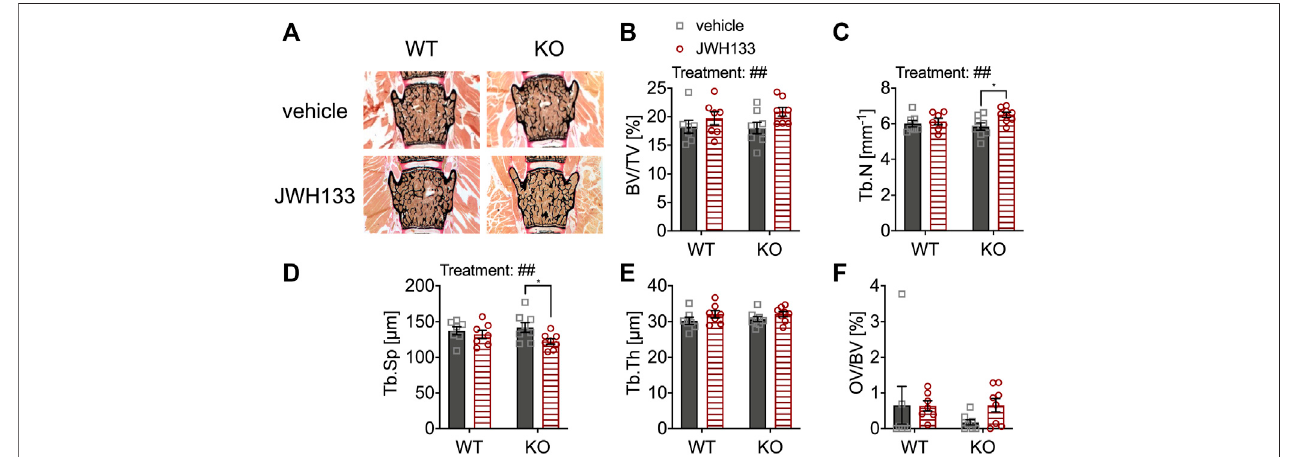
FIGURE 3 | JWH133 increased trabecular bone volume in mice. (A) Undecalci fi ed vertebral bodies (L4) stained after von Kossa/van Gieson (black = mineralized bone,red=osteoid)ofWTandp62KOmicethatweretreatedwitheithervehicleorJWH133. (B) Bonevolumepertissuevolume(BV/TV)wassimilarbetweengenotypes but was signi fi cantly increased by the treatment. (C) Trabecular number (Tb.N) was signi fi cantly increased by the treatment, and Bonferroni post hoc testing revealed a signi fi cant increase in JWH133-treated p62 KO mice compared to vehicle-treated p62 KO mice. (D) Trabecular separation (Tb.Sp) was signi fi cantly reduced by JWH133, and Bonferroni post hoc testing revealed a signi fi cant reduction in JWH133-treated p62 KO mice compared to vehicle-treated p62 KO mice. (E) Trabecular thickness(Tb.Th)wassimilarbetweengenotypesandshowedaweaktrendofthetreatmenttoincreasethethickness. (F) Osteoidvolumeperbonevolume(OV/BV)was increased in p62 KO mice after JWH133 treatment but did not reach signi fi cance due to high variability. Male mice were aged 3 months by the beginning of the experiment and were treated for 5 days with vehicle or JWH133. Data were analyzed by using ordinary two-way ANOVA and Bonferroni adjusted p values, * p < 0.05, ** p < 0.01, *** p < 0.001. All error bars show mean ± SEM. Squares and circles represent individual data points. WT vehicle N = 7, KO vehicle N = 8, WT JWH133 N = 8, KO JWH133 N = 8.